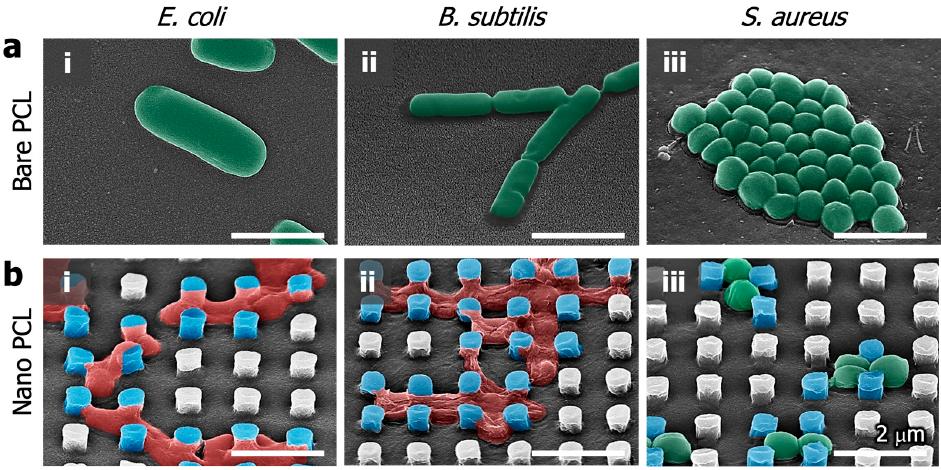
Figure 6. SEM images of ( i ) E. coli , ( ii ) B. subtilis and ( iii ) S. aureus cultured on the ( a ) bare PCL and ( b ) nanopillared PCL surfaces for 18 h.